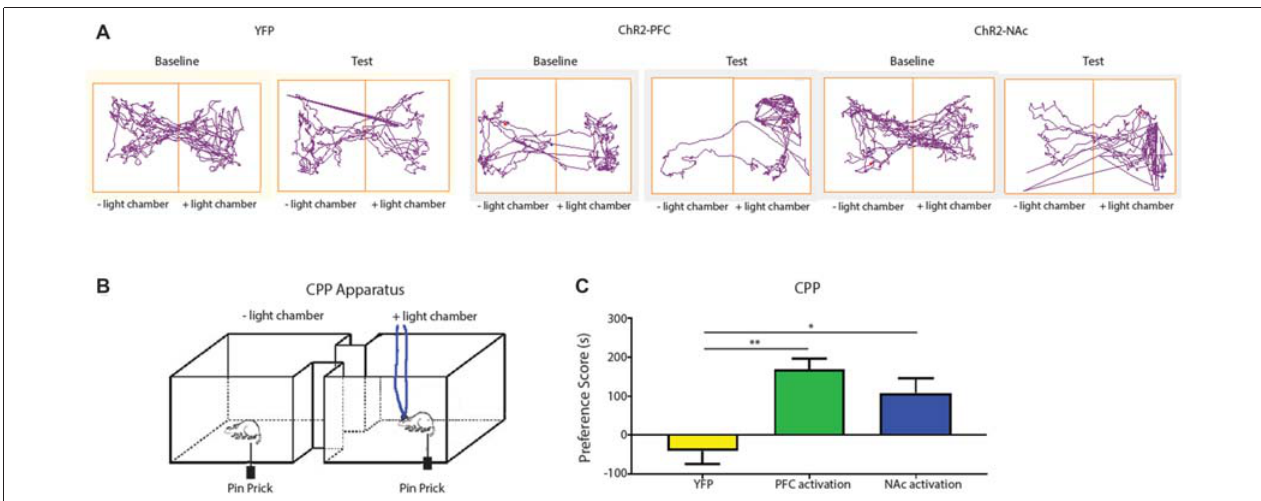
FIGURE 7 | Activation of the corticostriatal circuit regulates the aversive response to acute pain. (A,B) Experimental set up for CPP test for acute pain. In each chamber, rats received peripheral noxious stimulation. One of the chambers was paired with optogenetic treatment; the other chamber was paired with no treatment. Rat movement was recorded with ANY-maze software. (C) A comparison of preference scores from control activation (using YFP only without opsin expression), activation with ChR2 in the PFC, and activation with ChR2 in the NAc. n = 6, p = 0.0016 comparing YFP with PFC activation; p = 0.021 comparing YFP with NAc activation. One-way ANOVA with Bonferroni post-test. Error bars show mean and SEM. ∗ p < 0.05, ∗∗ p < 0.01.